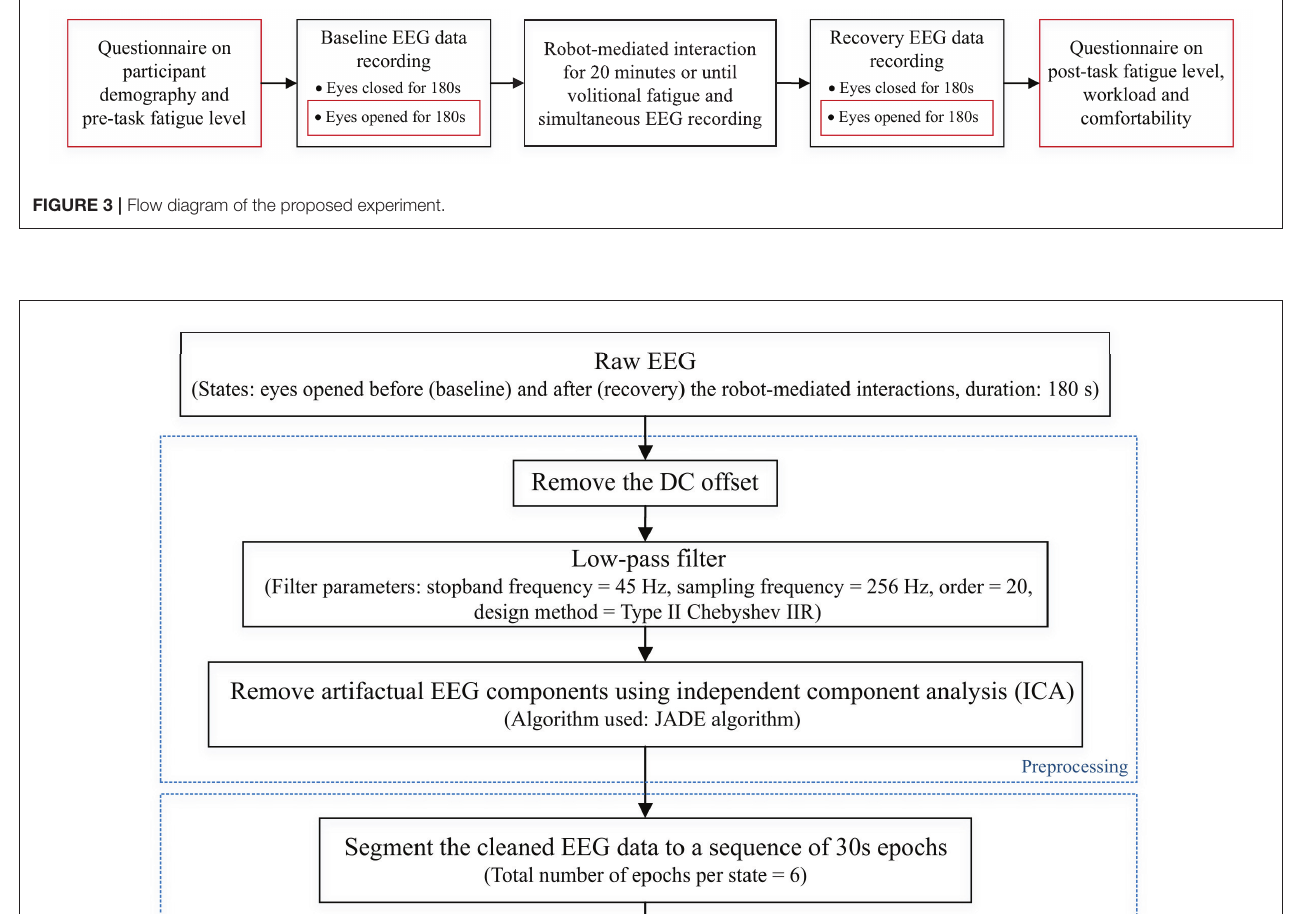
Frontiers in Neurorobotics |